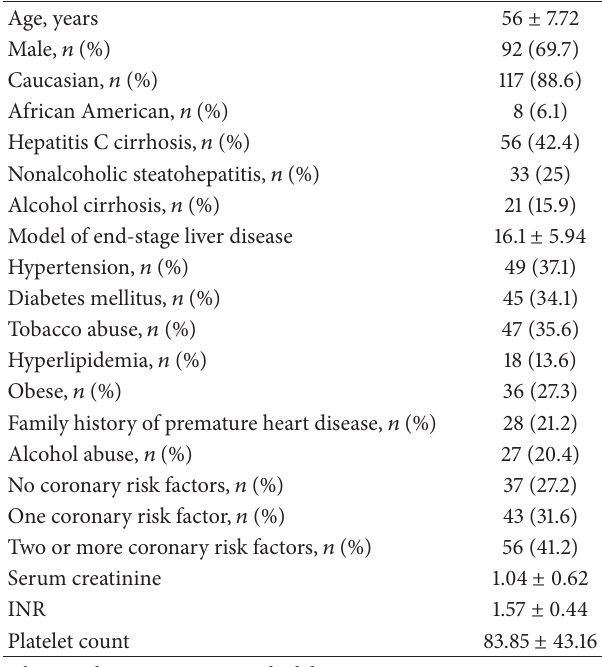
Table 1: Clinical characteristics of our entire study cohort.